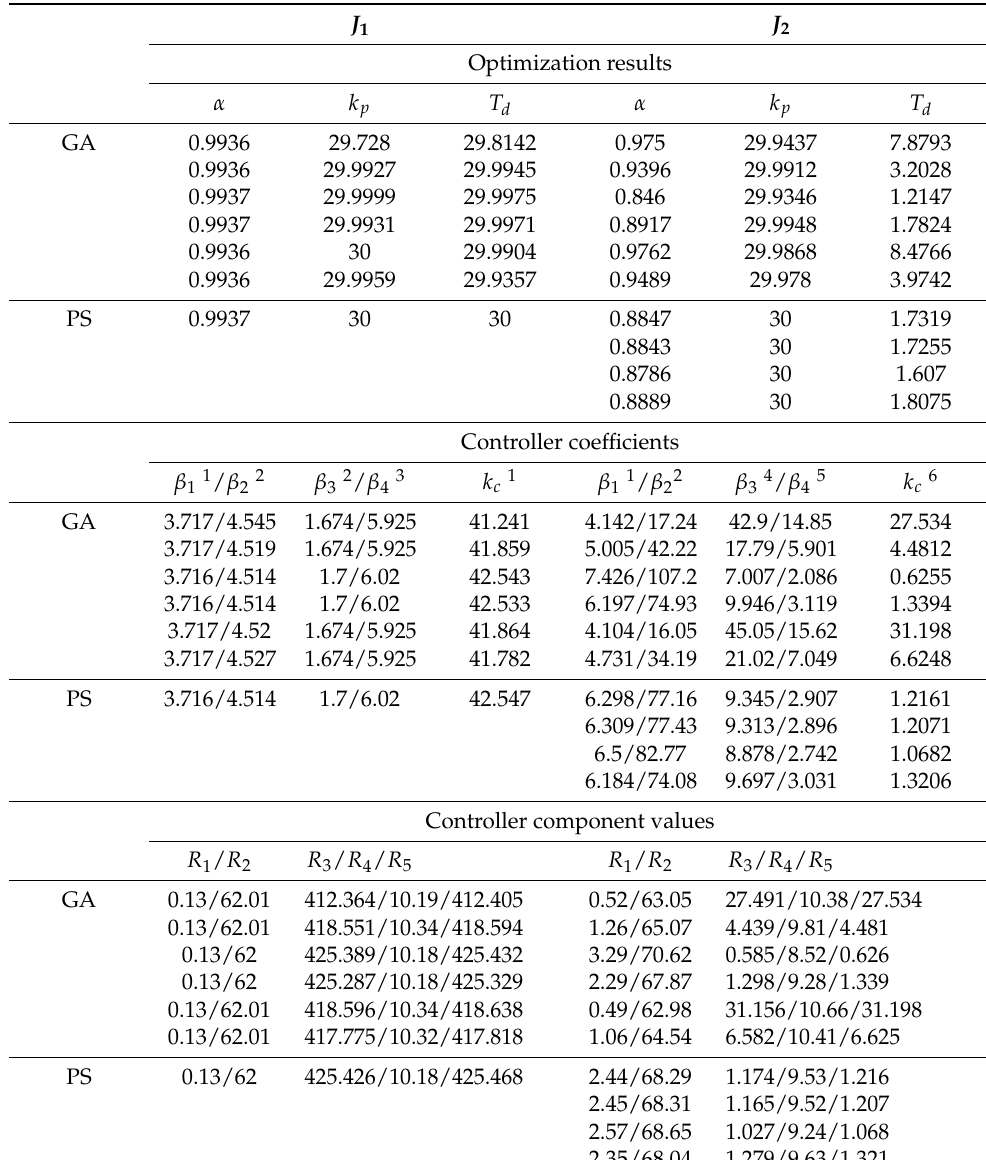
Table 5. Optimized parameters, controller coefficients and component values from minimizing criteria (9) and (10) without constraint over α . Units for R 1 , R 2 are in Ω , R 3 , R 5 in M Ω and R 4 in k Ω . J 1 J